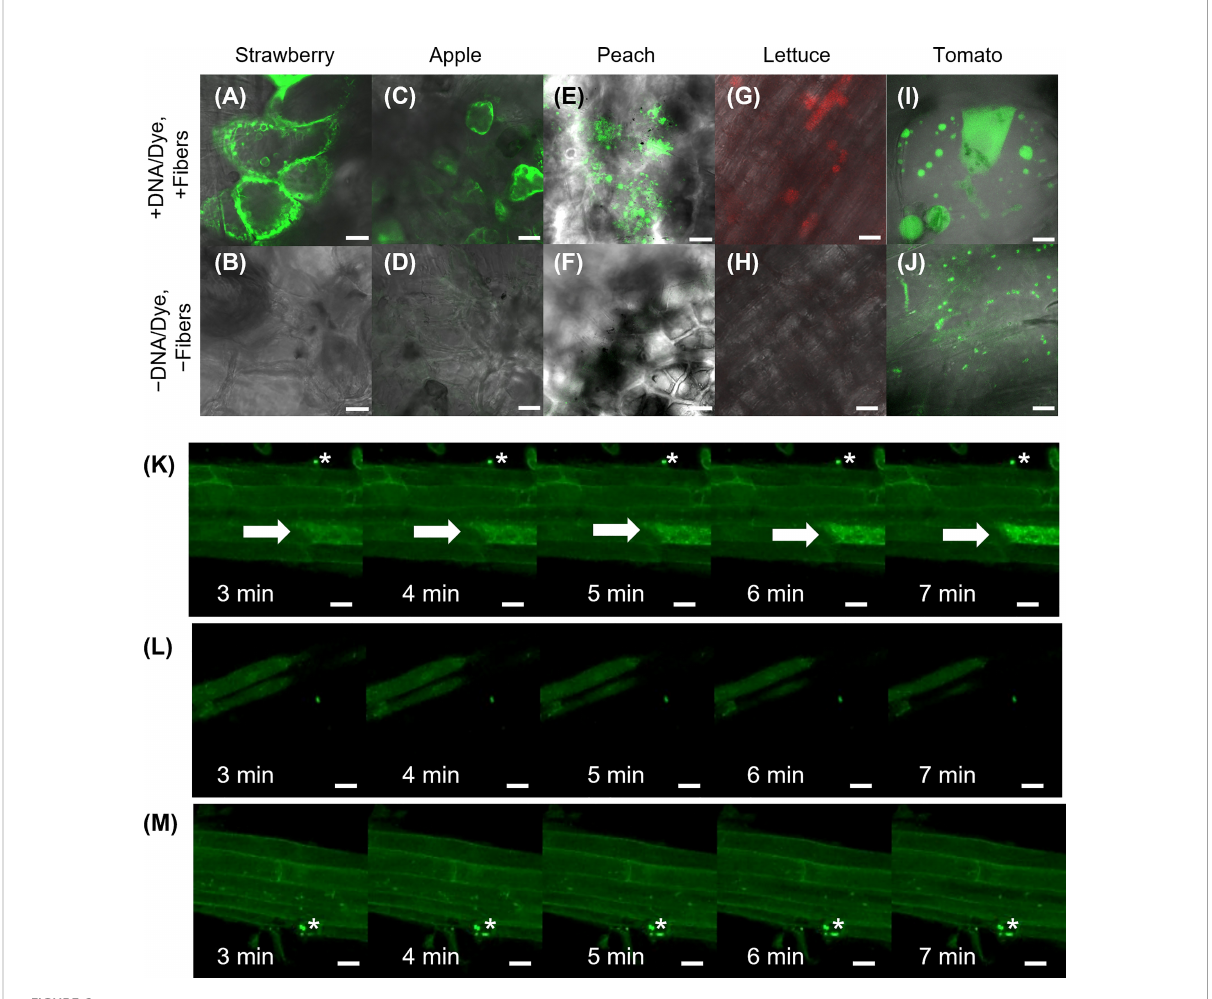
FIGURE 6 Application of VACNFs to curved organ surfaces. Images were generated using fl uorescence confocal microscopy. Fluorescein dye was delivered to store-bought strawberry (A) , apple (C) , and peach (E) via fi bers with 35 m m pitch with the on-plant method. (G) TAMRA dye was delivered to lettuce roots using the on-plant method with fi bers with 10 m m pitch. (I) DNA (p35S:AALP:GFP/pUC) was delivered to store-bought tomato fruit and GFP fl uorescence was imaged 40 h after delivery via on-plant method with fi bers with 20 m m pitch. The area shown is approximately one large cell. Panels (B, D, F, H, and J) show no-treatment controls of plant tissue for panels (A, C, E, G, and I) , respectively. (K – M) DNA encoding FlincG was delivered to Arabidopsis roots via VACNFs with 35 m m pitch (on-chip method), and expression was assessed after 36 h. (K) 36 h after FlincG delivery, Arabidopsis roots were treated with Pep1 peptide (panels show different time points after exposure to elicitor Pep1 (20 nM)) (+DNA-FlincG, + fi bers, +Pep1). The white arrow points to the transformed cell with signal increasing over time. (L) 36 h after FlincG delivery, Arabidopsis roots were treated with water (panels show different time points after exposure to water, which does not trigger production of cGMP) (+DNA-FlincG, + fi bers, +water). (M) Arabidopsis roots with fi bers without biosensor delivery treated with Pep1 ( − DNA, + fi bers, +Pep1). Scale bars are 20 m m. (A – F) are single images (0.5 m m thick) captured via confocal microscopy. G, H are maximum projections of 118 m m z-stacks and I-M are maximum projections of 40 m m z-stacks. * denote regions with fi